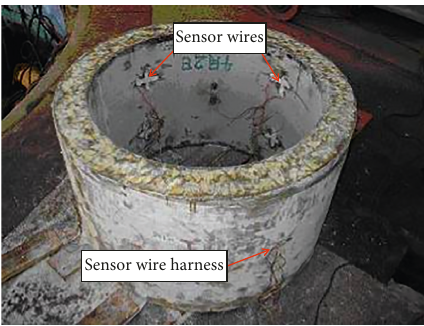
Figure 5: Shaft lining model and concrete surface measurement points.